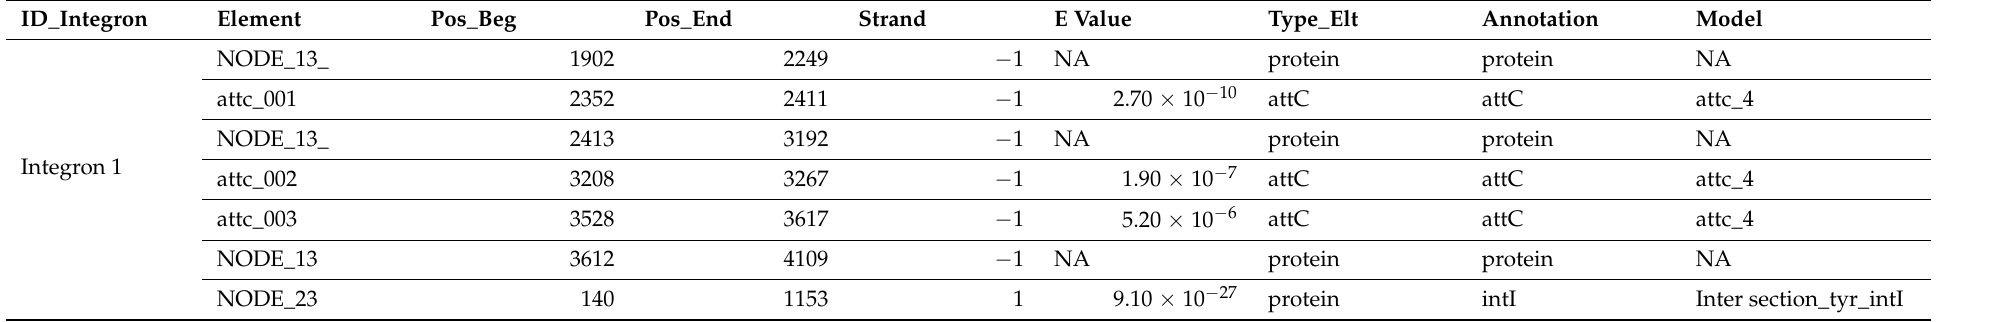
Table 4. Integron and integron-related recombination sites ( attC ) detected in isolated K6 and